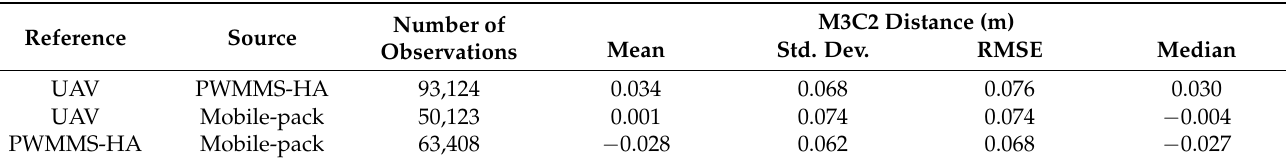
Table 7. Discrepancy estimation based on model-to-model cloud comparison (M3C2) distance using A-1 (UAV), A-2 (PWMMS-HA), and A-3 (Mobile-pack)